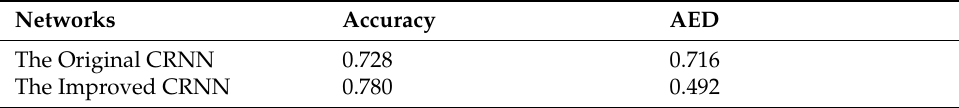
Table 5. The evaluation results in uyghur text recognition.